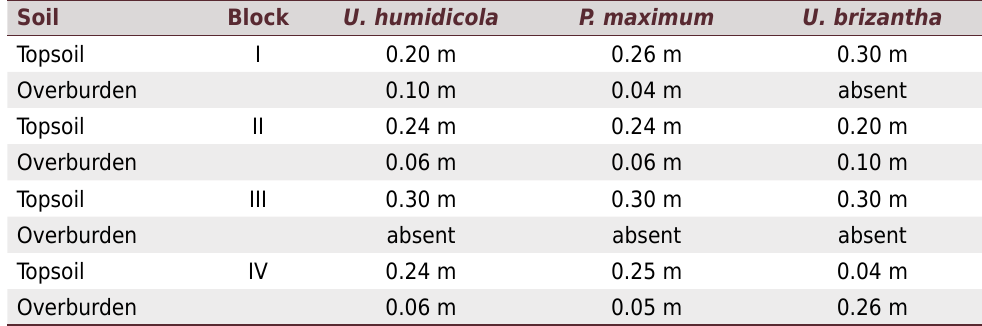
Table 3. Thickness of the topsoil layer and presence of overburden in the different blocks and treatments to a soil depth of 0.30 m Soil Block